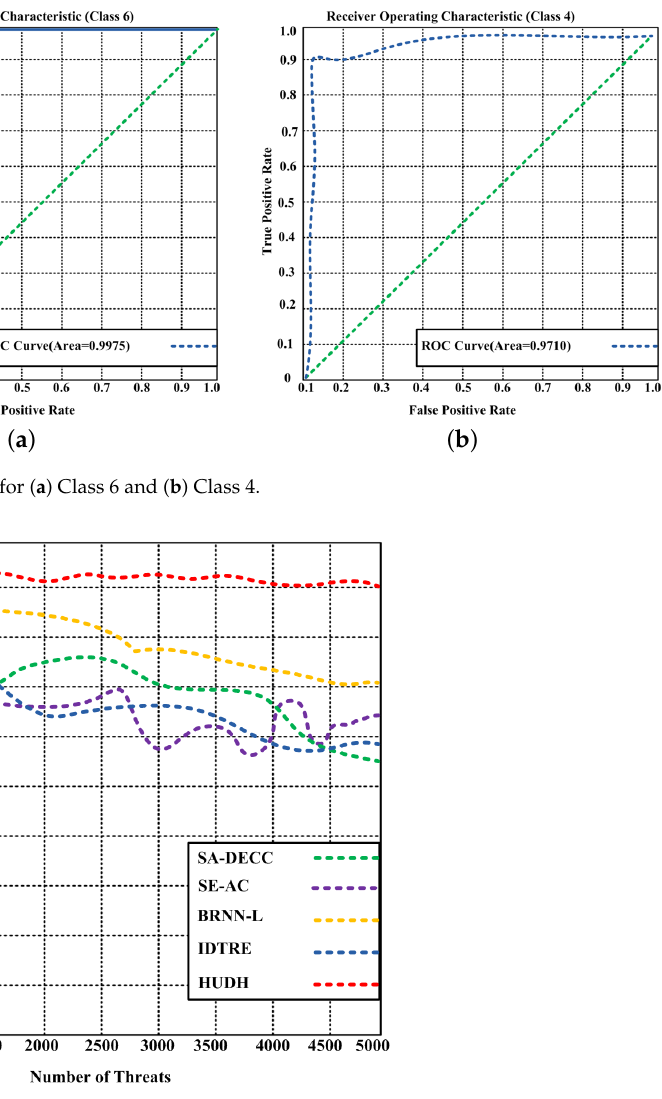
Figure 9. Average accuracy of the proposed HUDH and other state-of-the-art methods: IDTRE, BRNN-L, SE-AC, and SA-DECC, with a maximum of 5000